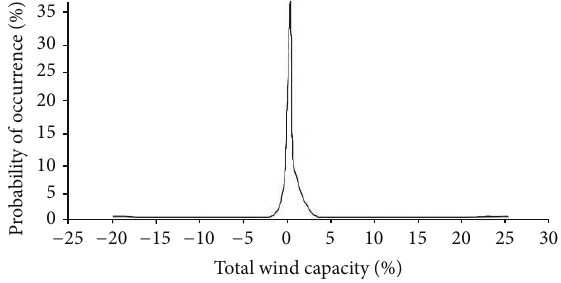
Figure 3: Example of minute-to-minute variability in wind power output (data source: Platts, data from National Renewable Energy Laboratory).